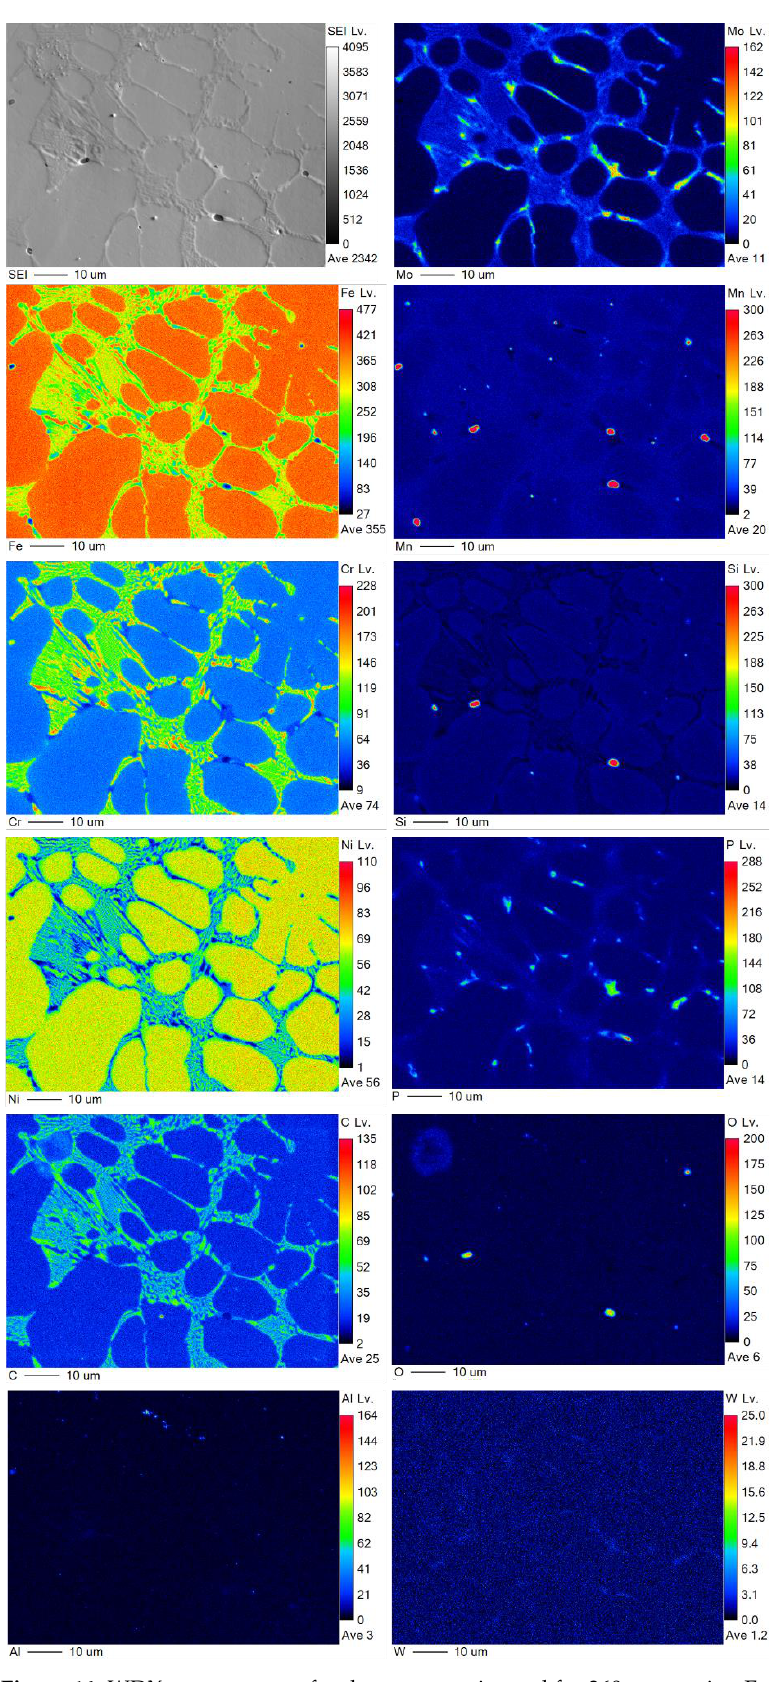
Figure 14. WDX measurement for the vacuum-sintered for 360 s, mapping Fe, Cr, Ni, Mo, Mn, Si, P, C, O, Al, and W.